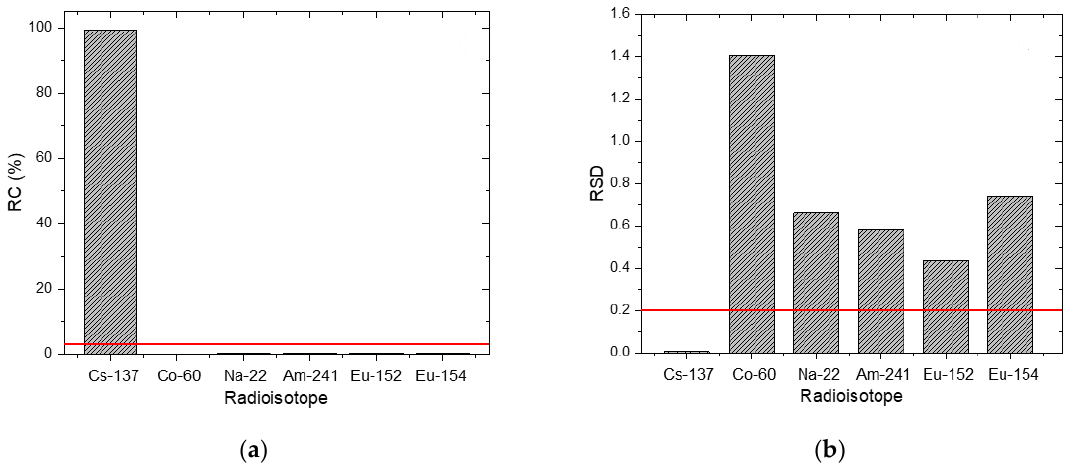
Figure 3. ( a ) RC and ( b ) RSD of the radioisotopes in the radioisotope library for a spectrum acquired for 300 s with a Cs-137 source buried in sand at a depth of 3 cm. The red lines denote criteria for the RC and RSD (i.e., 3% and 0.2, respectively).